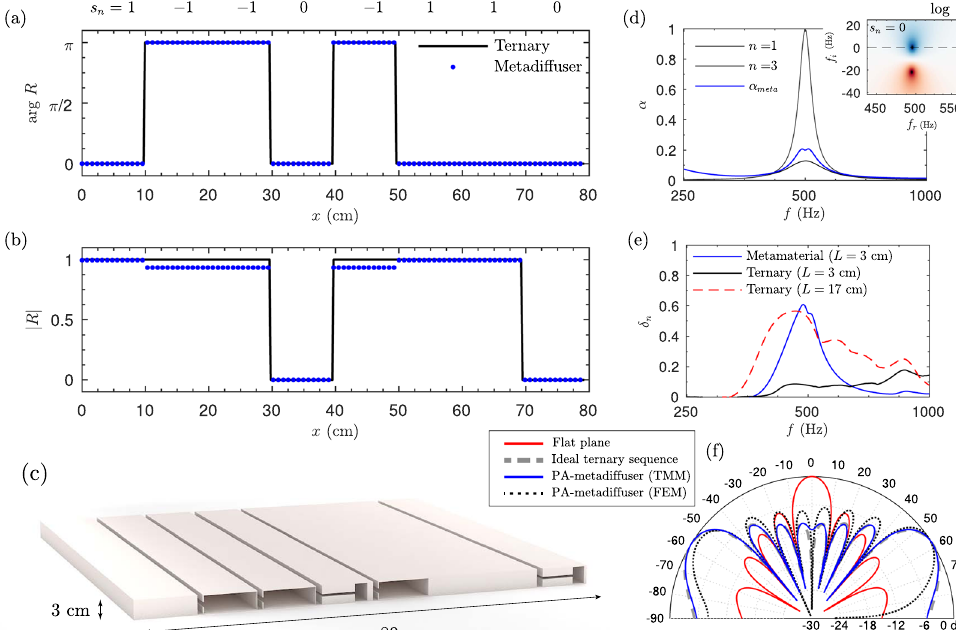
Figure 6. ( a ) Phase and ( b ) magnitude of the spatially dependent reflection coefficient for an ideal ternary sequence diffuser (black) and a PA-metadiffuser (blue dots). The ternary sequence used, s n , is shown on top. ( c ) Scaled scheme of the geometry of the hybrid PA-metadiffuser. ( d ) Frequency dependent absorption for the total structure (blue curve) and individual slits (black curves). The inset shows the complex frequency plane representation of the reflection coefficient for the perfect absorber slits, s n = 0. ( e ) Frequency dependent diffusion for the PA-metadiffuser of L = 3 cm (blue), a ternary sequence diffuser using phase gratings of L = 17 cm (dashed red) and ternary sequence diffuser using phase gratings of L = 3 cm (black). ( f ) Far field polar response at 500 Hz of a ternary sequence with N = 8 wells (dashed-grey), the PA-metadiffuser obtained by TMM (continuous black) and FEM (dotted black), and a plane reflector of the same width as the diffusers (red line).